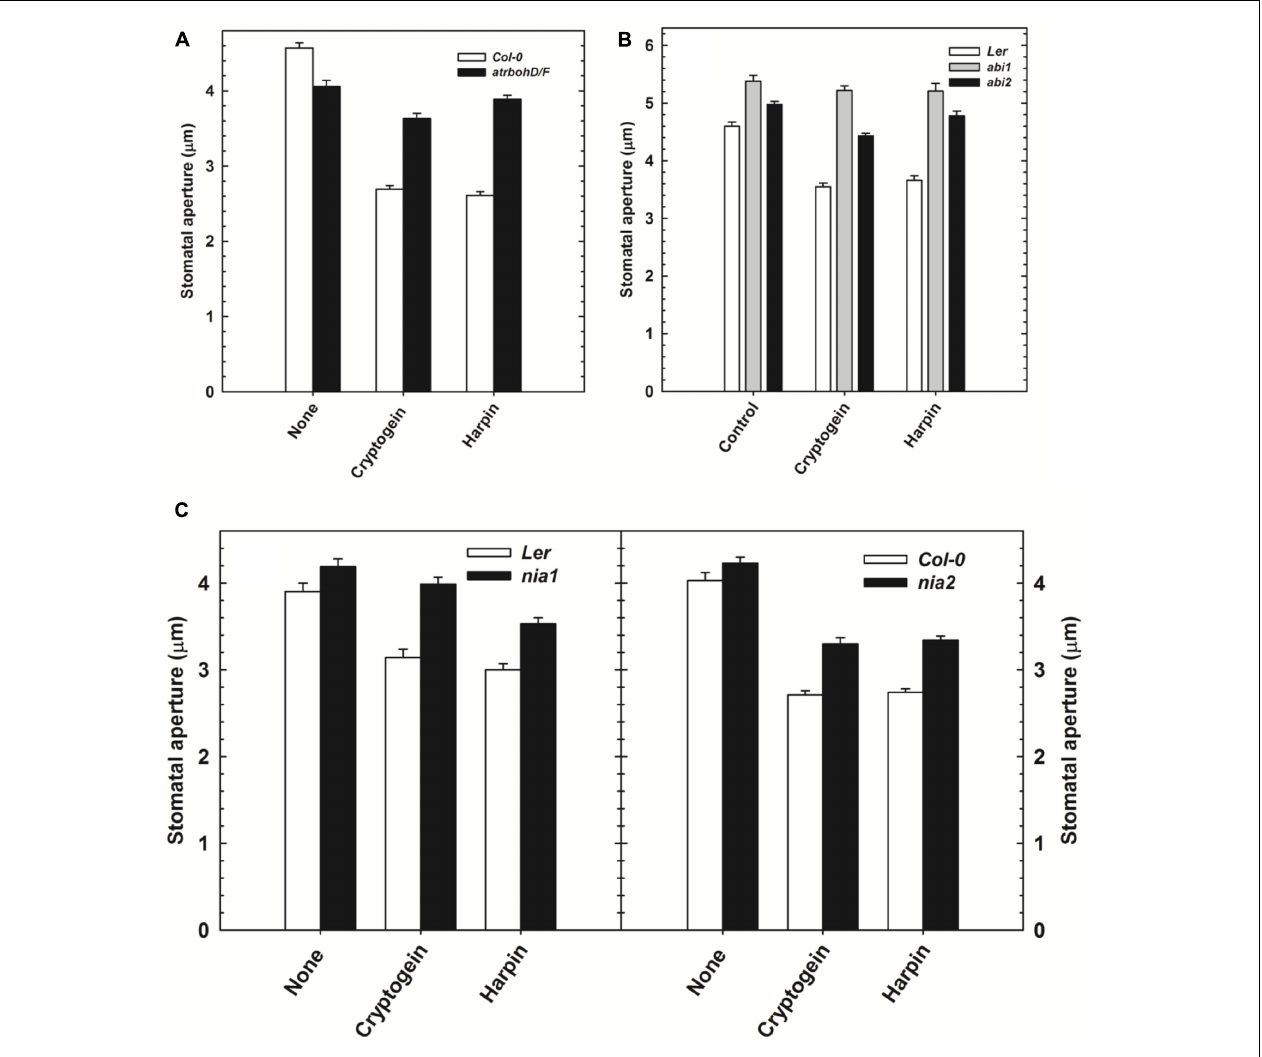
FIGURE 7 | The effect of microbial elicitors cryptogein and harpin on stomatal closure in Arabidopsis mutants. The stomatal closure by elicitors was partial in atrbohD/F (NADPH oxidase deficient mutant) plants compared with Col- 0 (wild type, WT) (A) . In contrast, the stomatal closure by elicitors was impaired in the abi1 (PP2C deficient) and partially impaired in abi2 (B) . The effects of microbial elicitors, cryptogein and harpin were partially relieved in the NR deficient mutants, nia1 and nia2 (C) . The data plotted in the graph are the averages of three different experiments on three different days. Further details are as in Figure 1 .